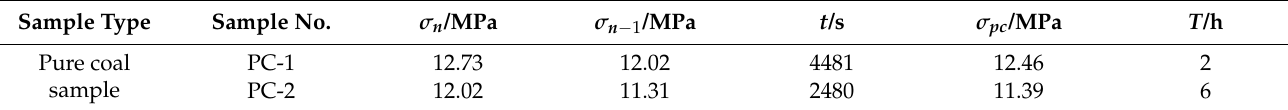
Table 3. σ n , σ n − 1 and t and creep coefficients of pure coal samples.